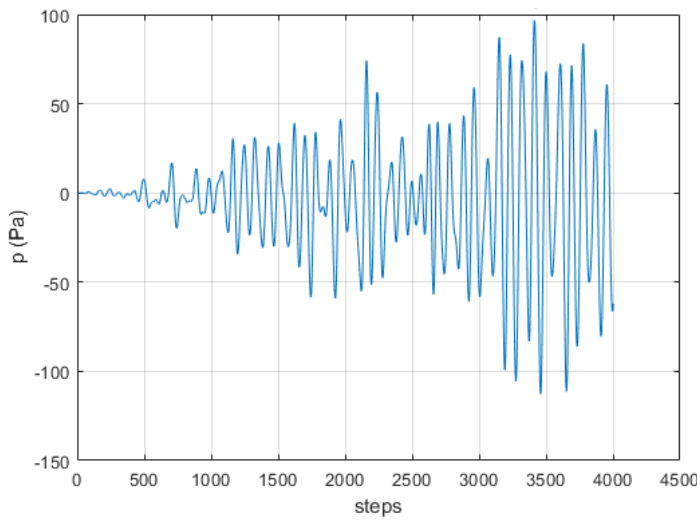
Figure 13. Pressure time history at the midpoint of the 3rd segment of the vertical beam. This segment’s Young modulus is 10 times smaller compared to the values of the remaining segments.